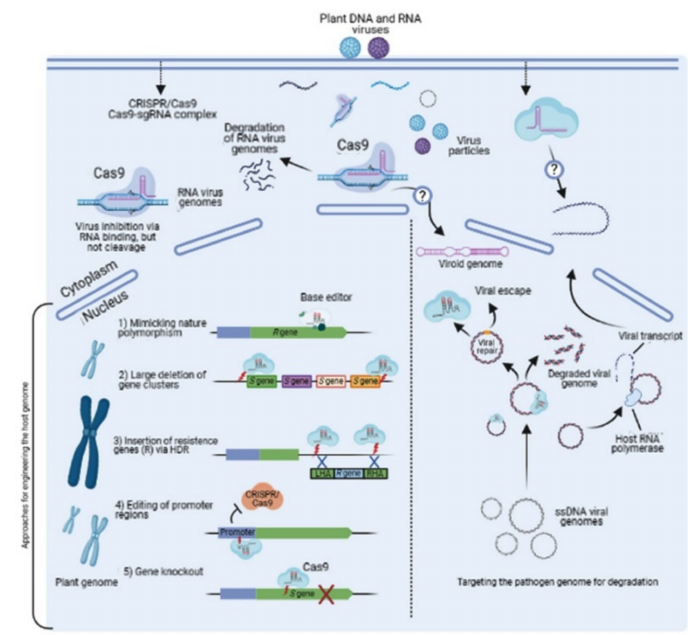
Figure 3. Plant virus-resistance strategies using Cas9 (illustration is adapted and modified from Zaidi et al. [24]).